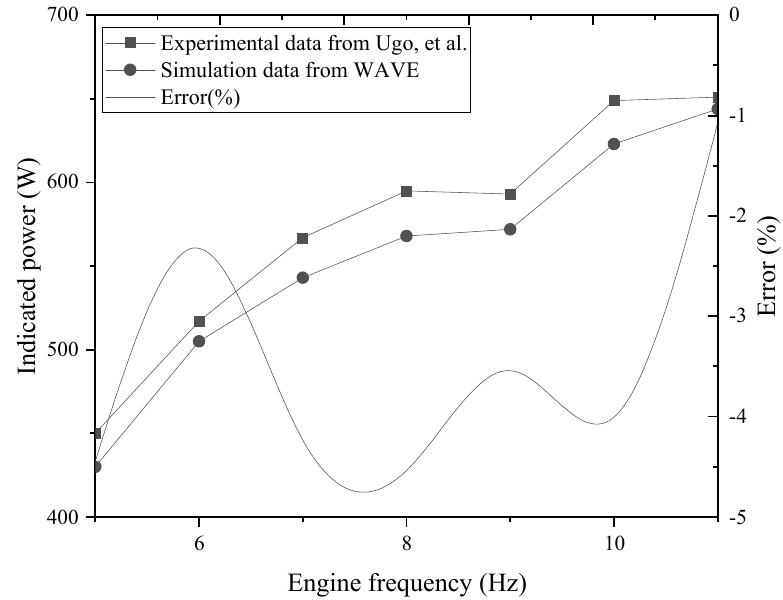
Figure 9. Indicated power comparison between the WAVE model and experimental data.